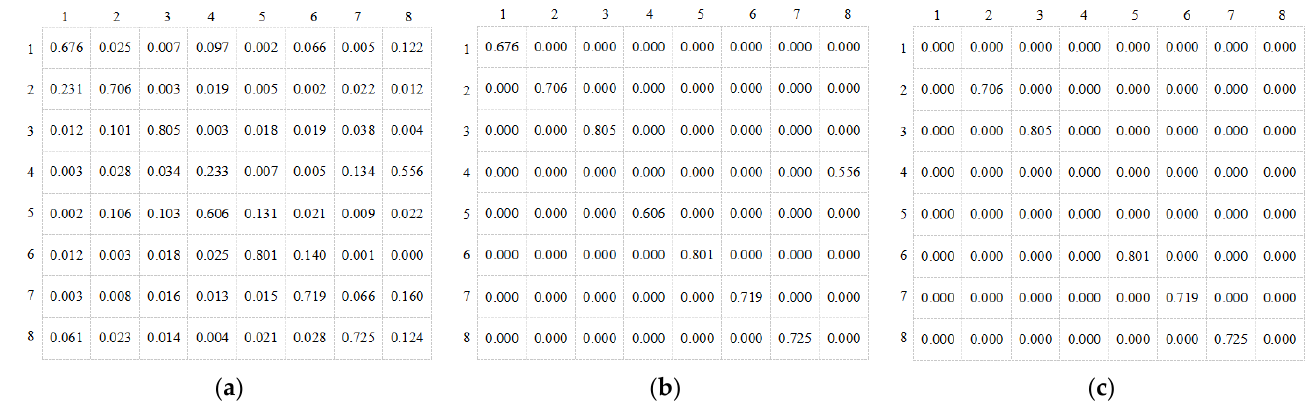
Figure 5. Temporal interaction matrices of different temporal sparsity ( δ ). ( a ) Temporal interaction matrix for δ = 0 ; ( b ) Spares temporal interaction matrix for δ = 0.5 ; ( c ) Spares temporal interaction matrix for δ = 0.7 .